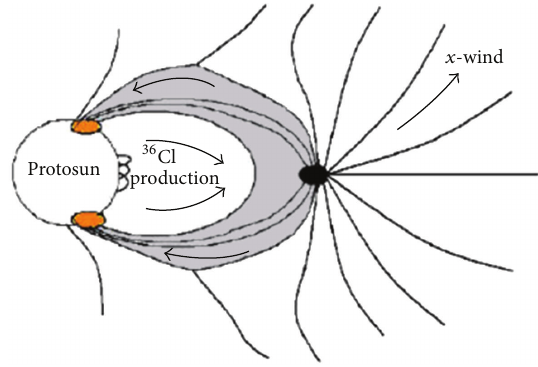
Figure1:Solarwindimplantationmodelofmagneticfieldgeometry for SLRs production via nuclear reactions. The gray area represents accretionflowonto“hotspots”onthePMSstar.SLRsproducedclose to the protosolar surface are implanted into CAI material which has fallen from the accretion flow (figure after Shu et al.